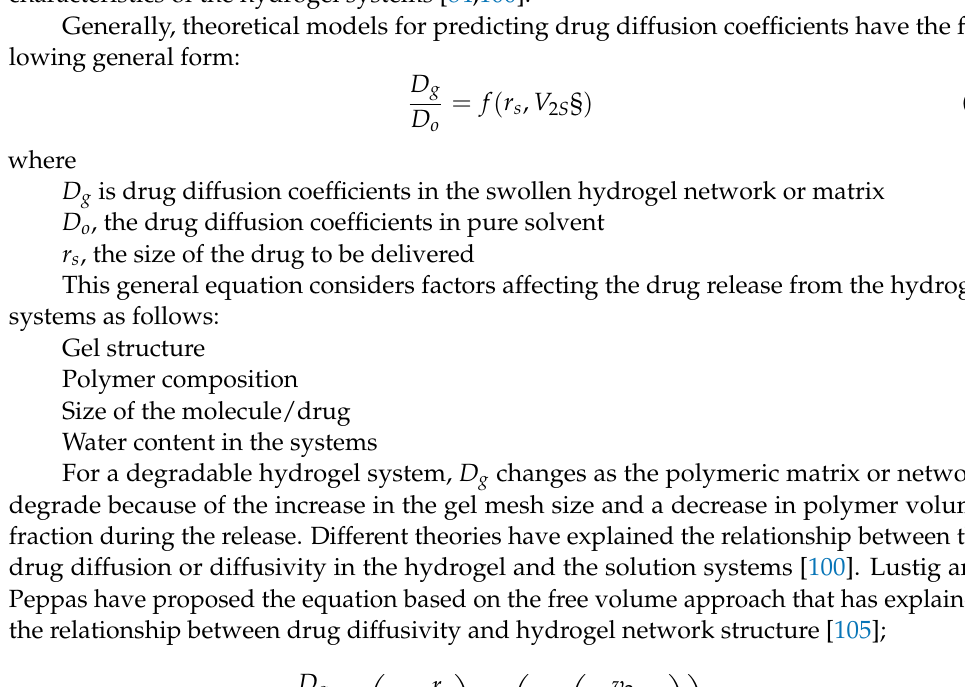
Slab n = 0.5 n = 1 Cylinder n = 0.45